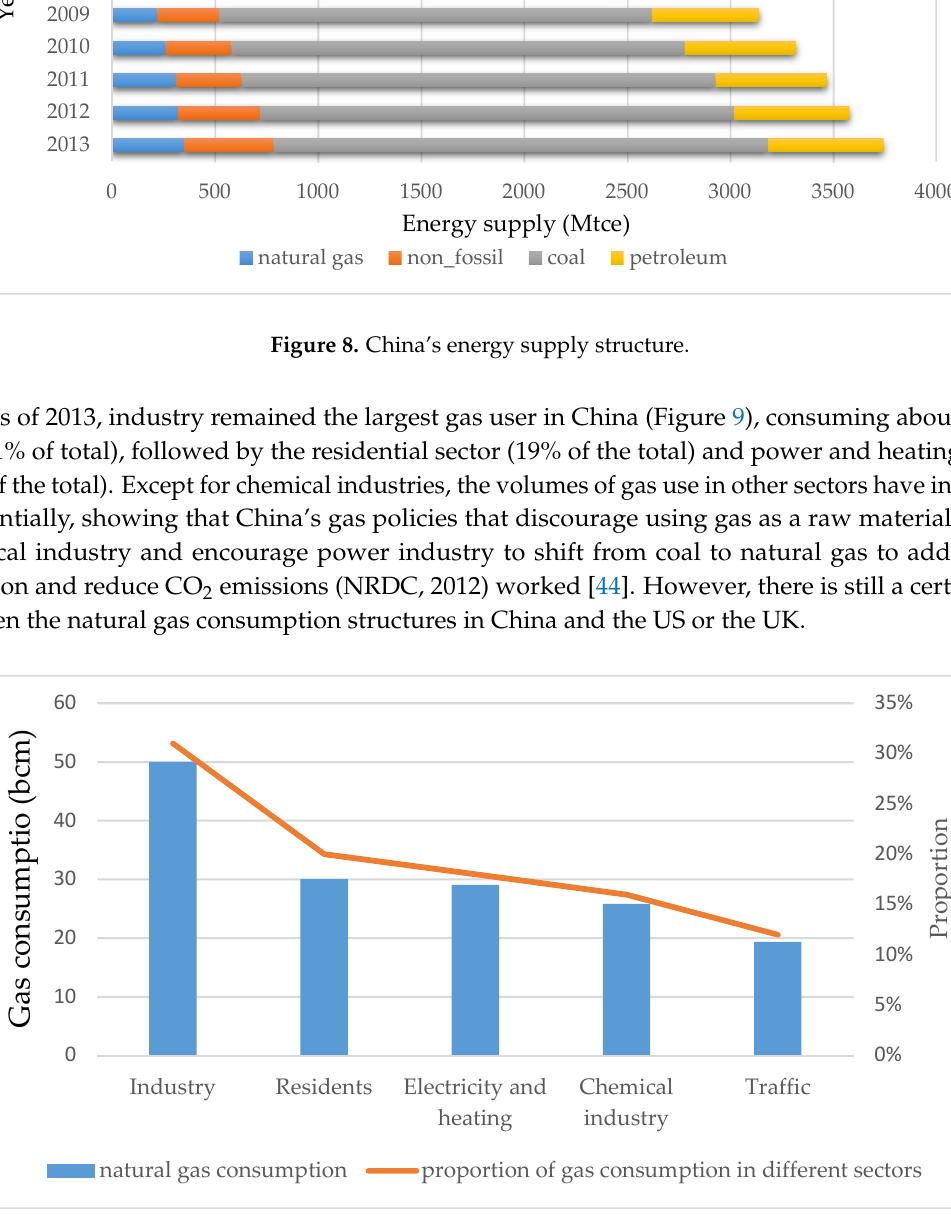
Figure 9. China’s natural gas consumption structure.